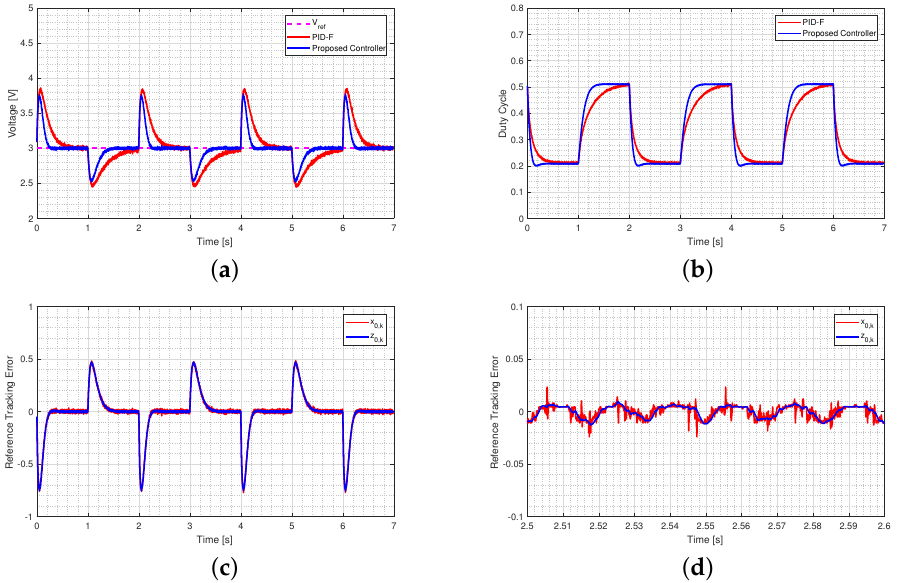
Figure 8. Input voltage variation performance of the proposed controller and a saturated discrete − time PID with τ = 25 µ s. ( a ) Output voltage and reference; ( b ) control output; ( c ) reference tracking error and its estimation; ( d ) reference tracking error detail.